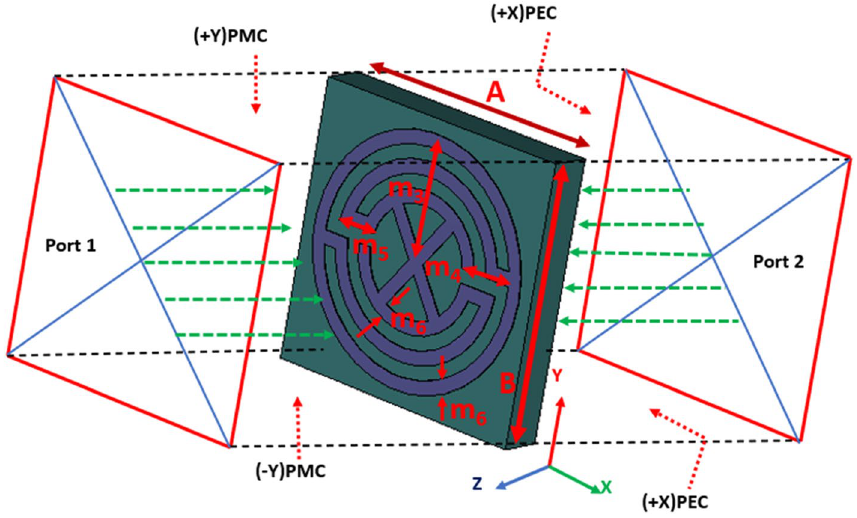
Figure 2. Simulation setup of MTM unit cell structure. Dimensions (mm): A = 10, B = 10, m3 = 4.5, m4 = 2, m5 = 1.5, and m6 = 0.5.